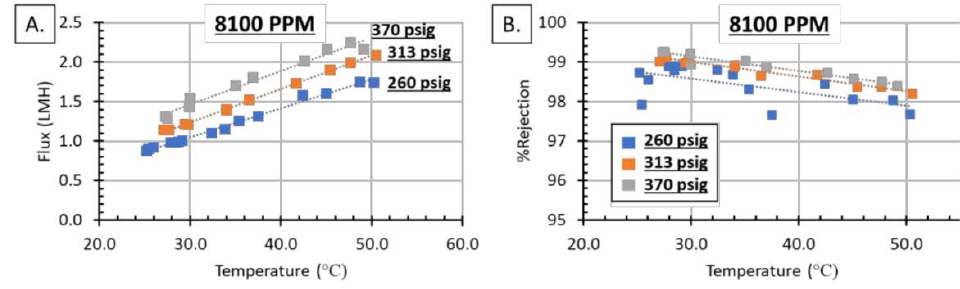
Figure 7. The FGD WW at 8110 PPM: ( A ) Flux increased linearly with temperature in the pressure and temperature range tested. Additionally, flux increased with increasing pressure. ( B ) %rejection decreased with increasing temperature and increased with increasing pressure.